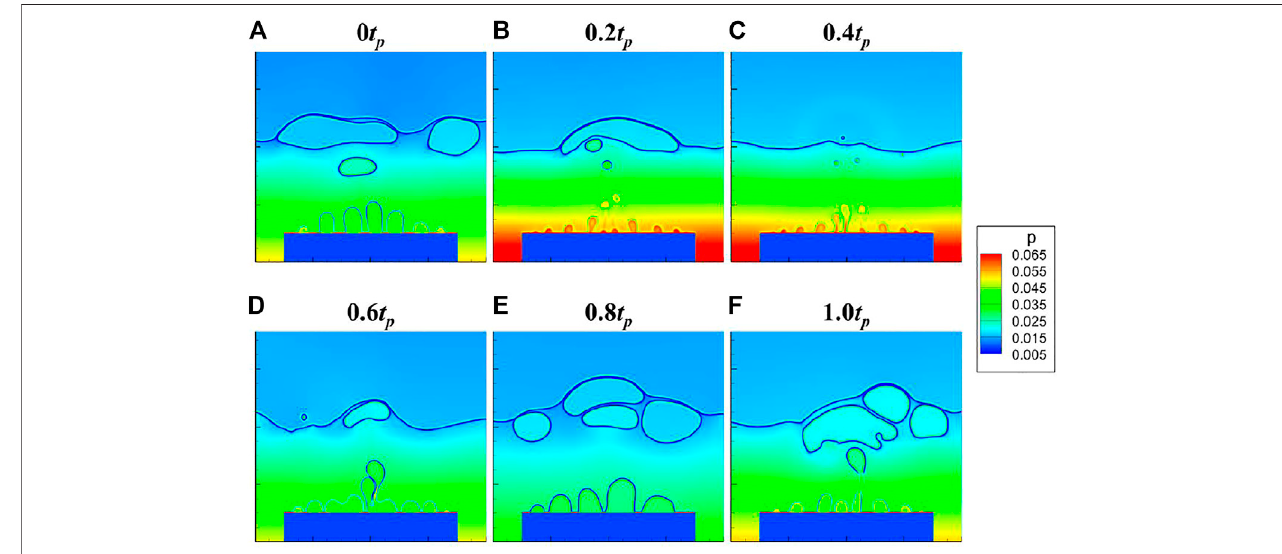
FIGURE 13 | Pressure fi eld around CHF under heaving conditions.